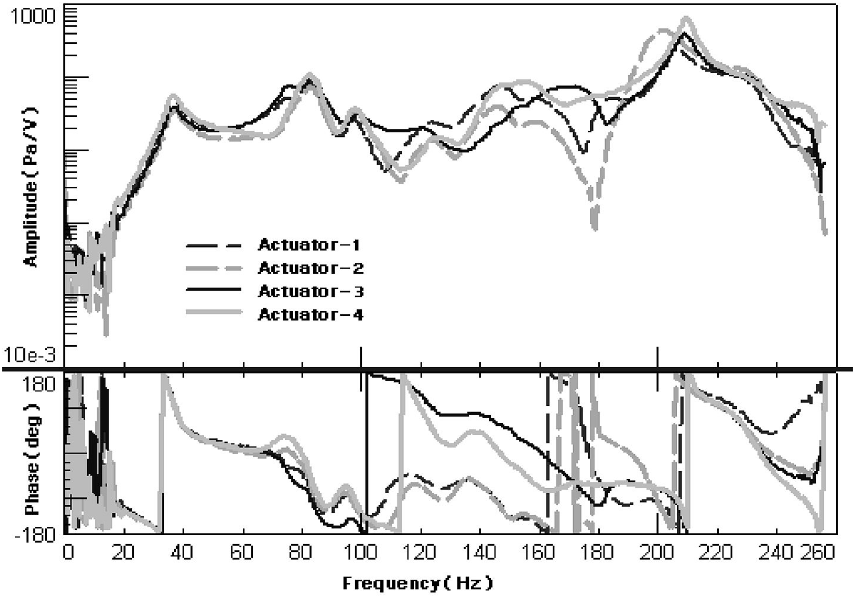
Fig. 10. Measured FRFs between the excitation of the actuators and the sound pressure.